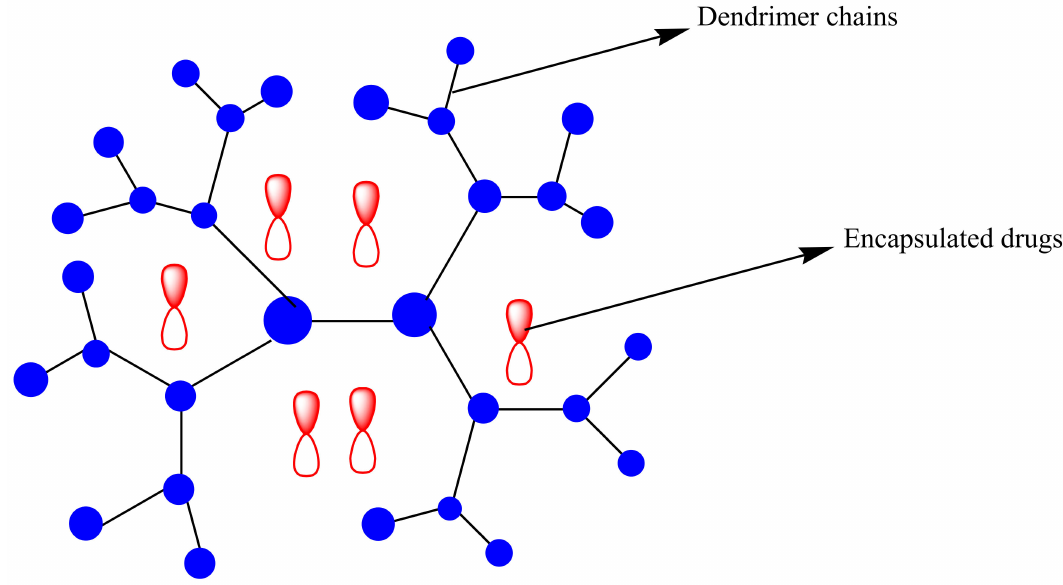
Figure 6. Schematic diagram of dendrimers encapsulated with